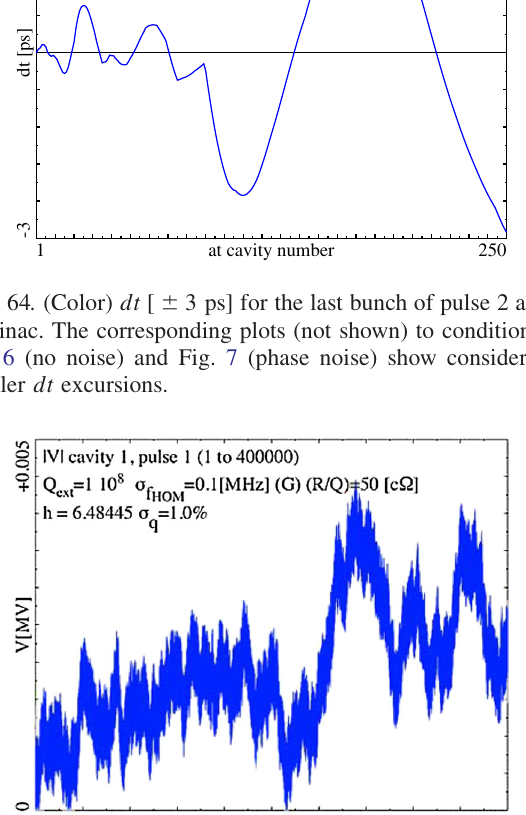
FIG. 65. (Color) The voltage of the first cavity (#1) (1st beam pulse) from passage of bunch 1 to 400 000. The first cavity is driven by bunch noise exclusively; no ‘‘self-amplification’’ could take place yet. The voltage starts at